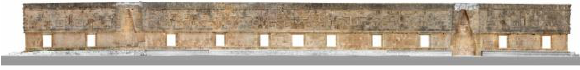
Figure 15. Photogrammetric view of the Palace of the Governor’s front facade elevation. (Project MAYATECH 2019).